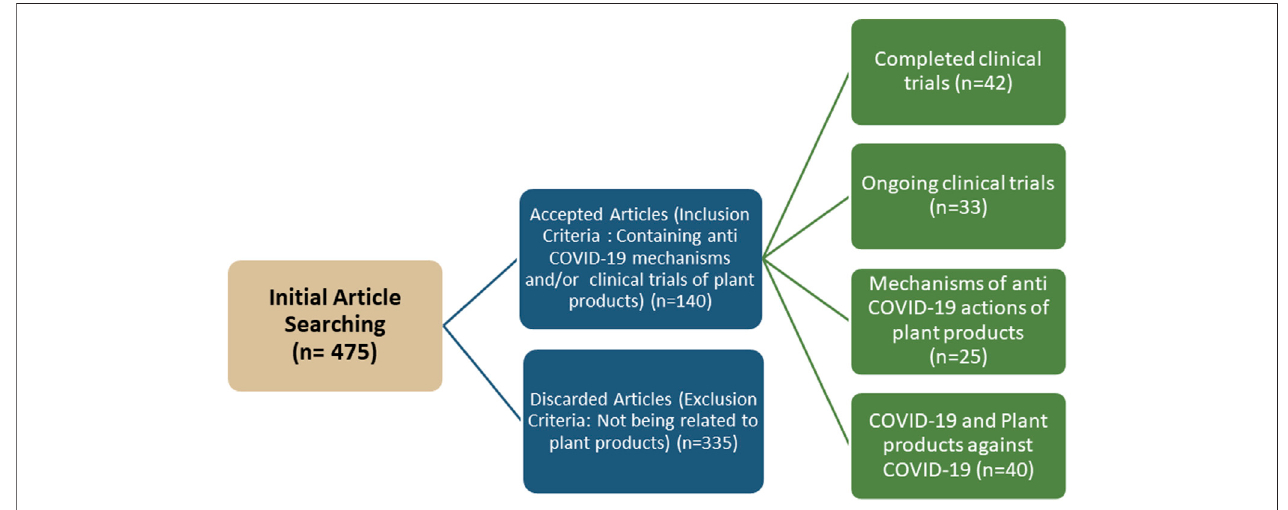
FIGURE 3 | Flowchart for article search, screening and selection in literature